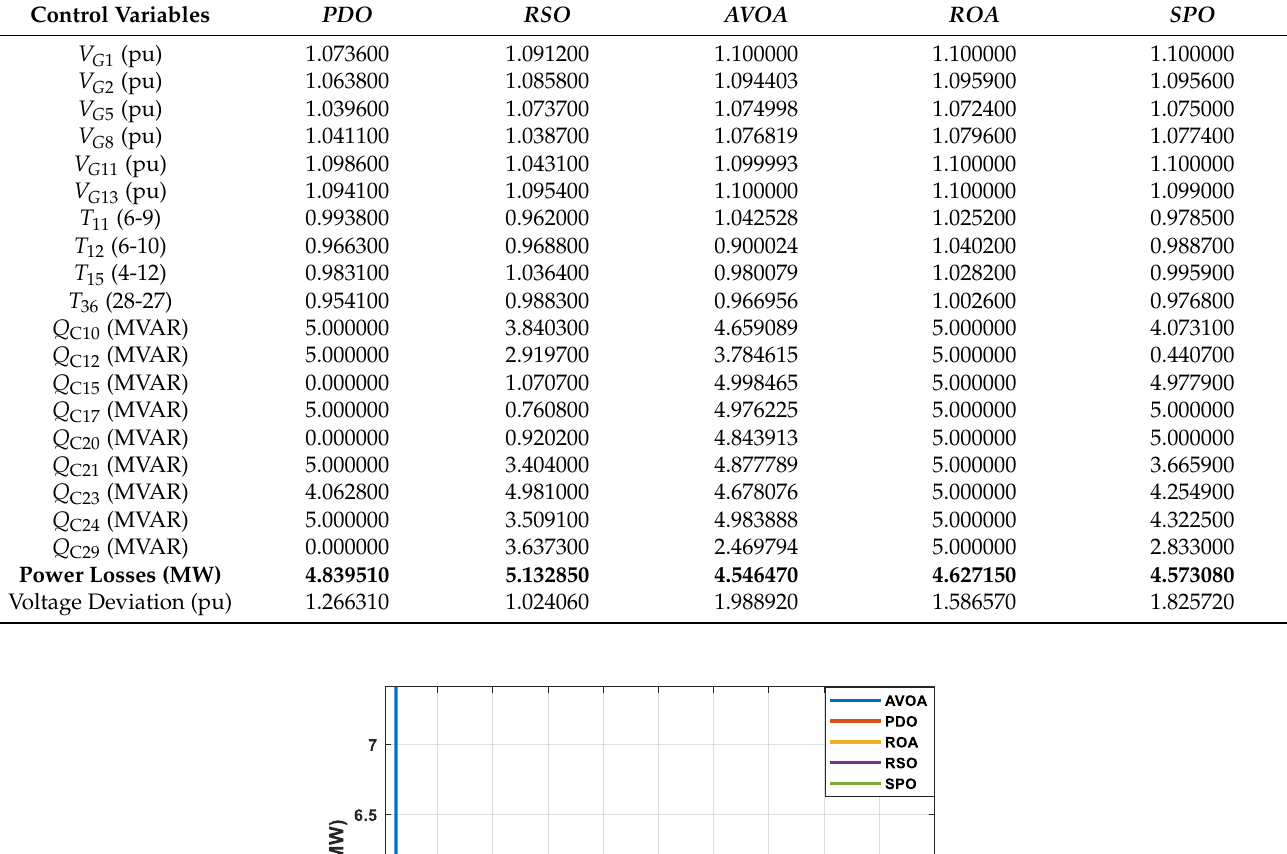
Table 12. Optimal IEEE 30-bus test system control variables for decline power losses.